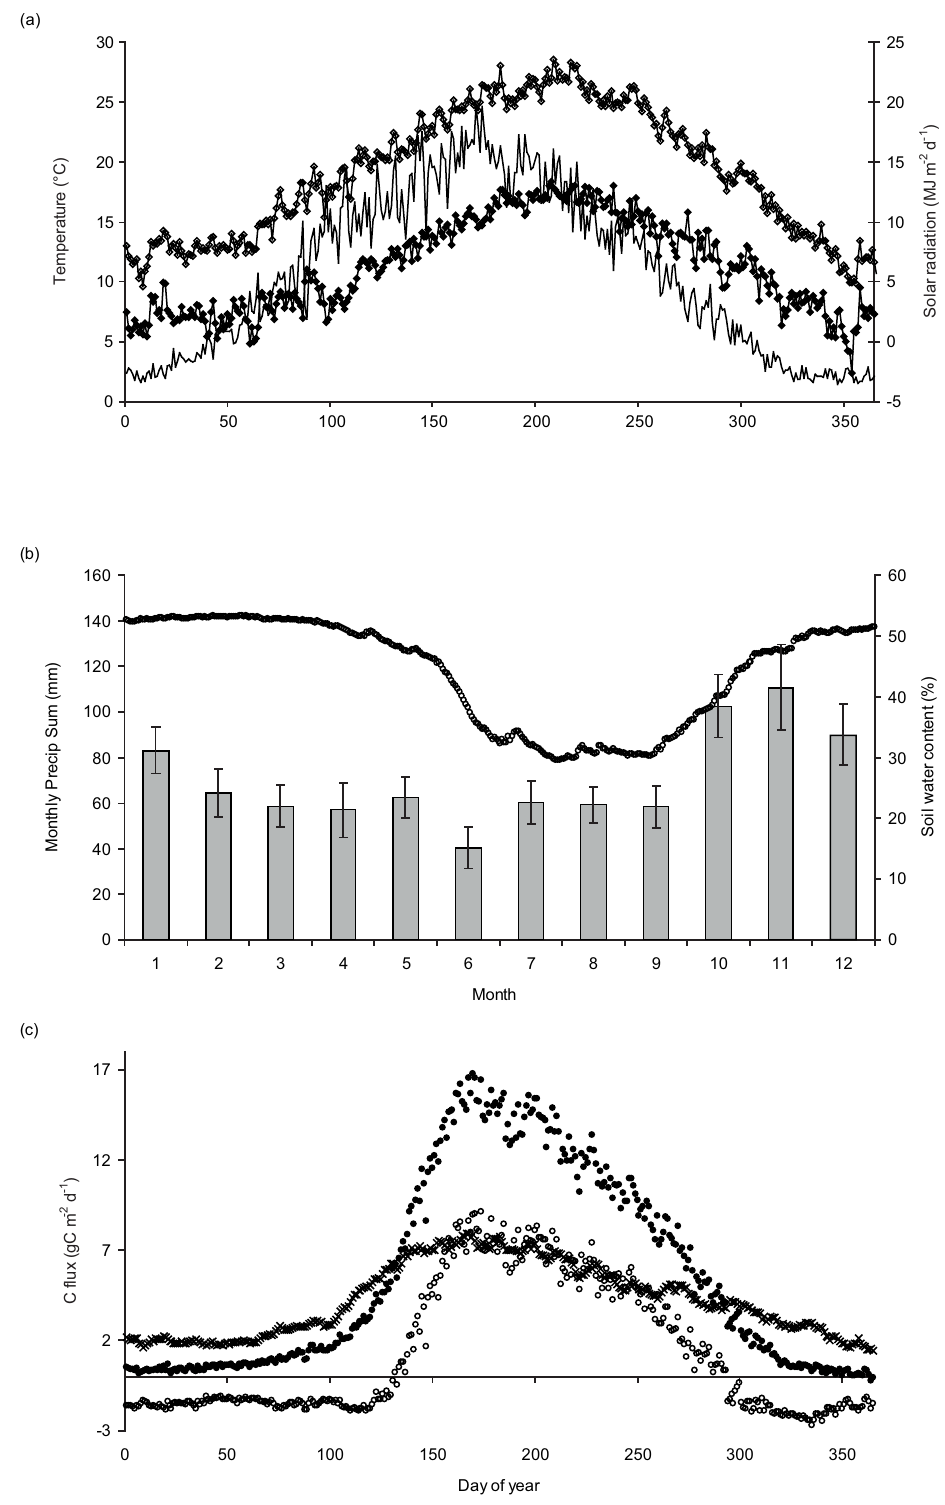
Fig. 3. Average annual cycle of key climatic variables and CO 2 flux components between 1999–2010 for the oak plantation at the Straits Inclosure, Alice Holt Forest: (a) T max (open symbols), T min (closed symbols) and incident solar radiation (solid line); (b) mean monthly precipitation (error bars represent ± 1 standard error, n = 12) and volumetric soil water content recorded under grass nearby (open symbols); and (c) daily GPP (solid circles), R eco (crosses) and NEP (open